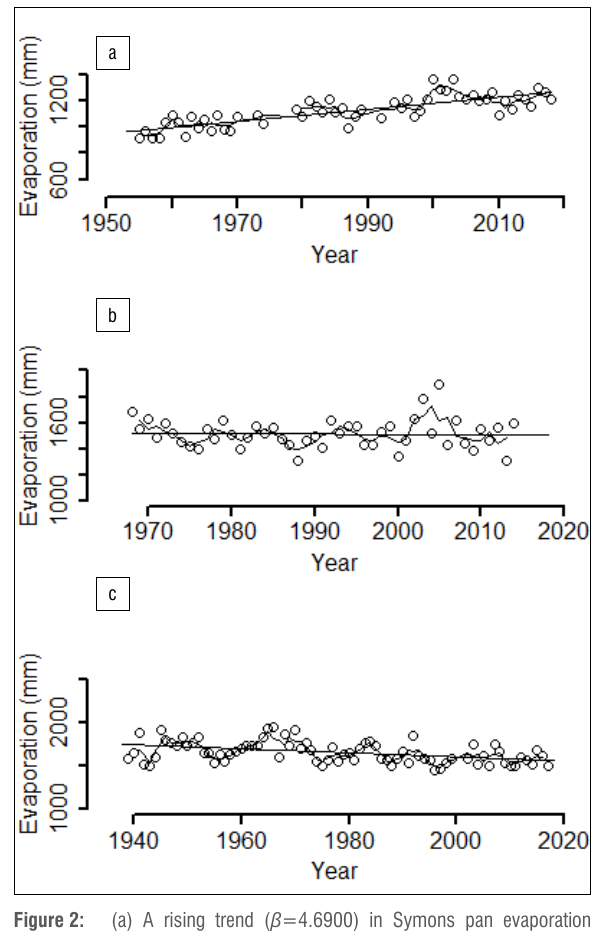
Figure 2: (a) A rising trend ( β =4.6900) in Symons pan evaporation on Table Mountain, Western Cape, station G2E004 Tafelberg. (b) No significant trend ( β =-0.0615), Bronkhorstspruit Dam, Gauteng Province, station B2E001. (c) A declining trend ( β =- 2.2166) Vaal Dam, Gauteng Province, station C1E001.